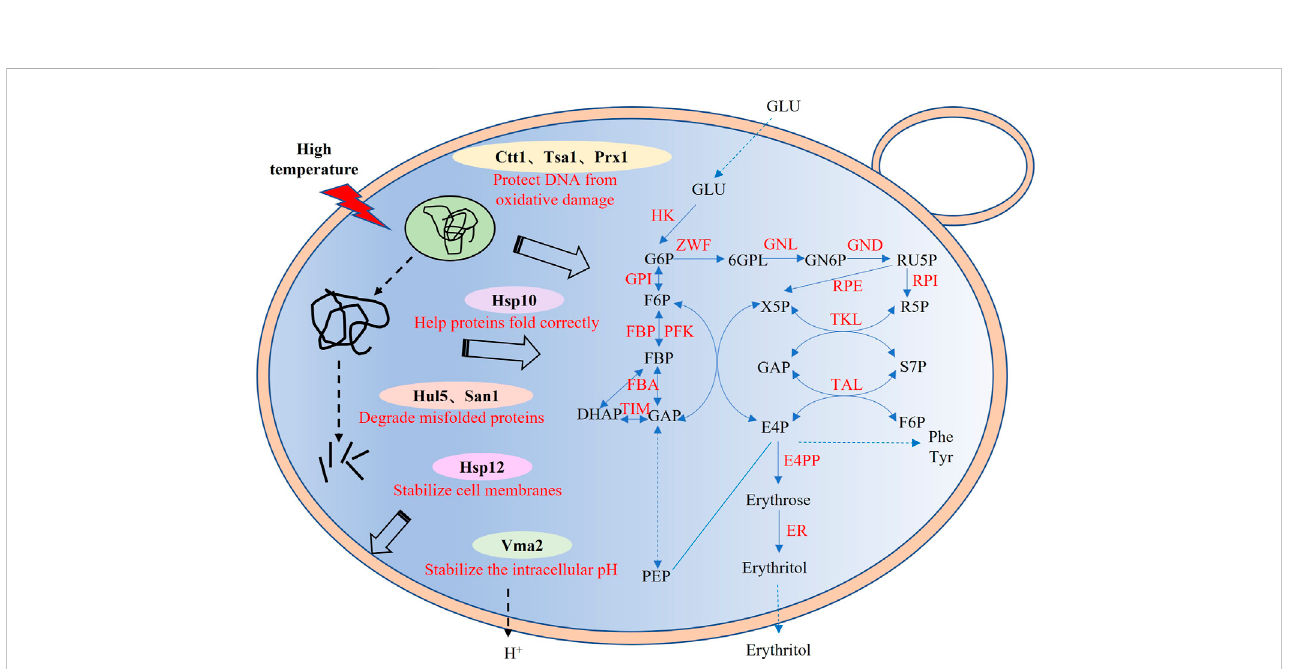
Synthetic pathway of erythritol and potential protective mechanism of heat-resistant devices. GLU, glucose; G6P, glucose-6-P; F6P, fructose-6-P; FBP, fructose-1,6-2P; DHAP, dihydroxyacetone phosphate; GAP, glyceraldehyde-P; Ru5P, ribulose-5P; X5P, xylulose-5-P; R5P, ribose-5-P; S7P, sedoheptulose- 7-P; E4P, Erythrose-4-P; 6GPL, 6-P-gluconolactone; GN6P, 6-P-gluconate; PEP, phosphoenolpyruvate; HK, hexokinase; GPI, glucose-6-phosphate isomerase; FBP, fructose-1,6-bisphosphatase; PFK, 6-phosphofructokinase; RPE, ribulose-phosphate 3-epimerase; FBA, fructose-bisphosphate aldolase; TIM, triosephosphate isomerase; ZWF, glucose-6-phosphate 1-dehydrogenase; RPI, ribose 5-phosphate isomerase; GND, 6-phosphogluconate dehydrogenase; TKL, transketolase;TAL, transaldolase; GNL, 6-phosphogluconolactonase; E4PP, erythrose 4-phosphate phosphatase; XR, xylitol reductase.